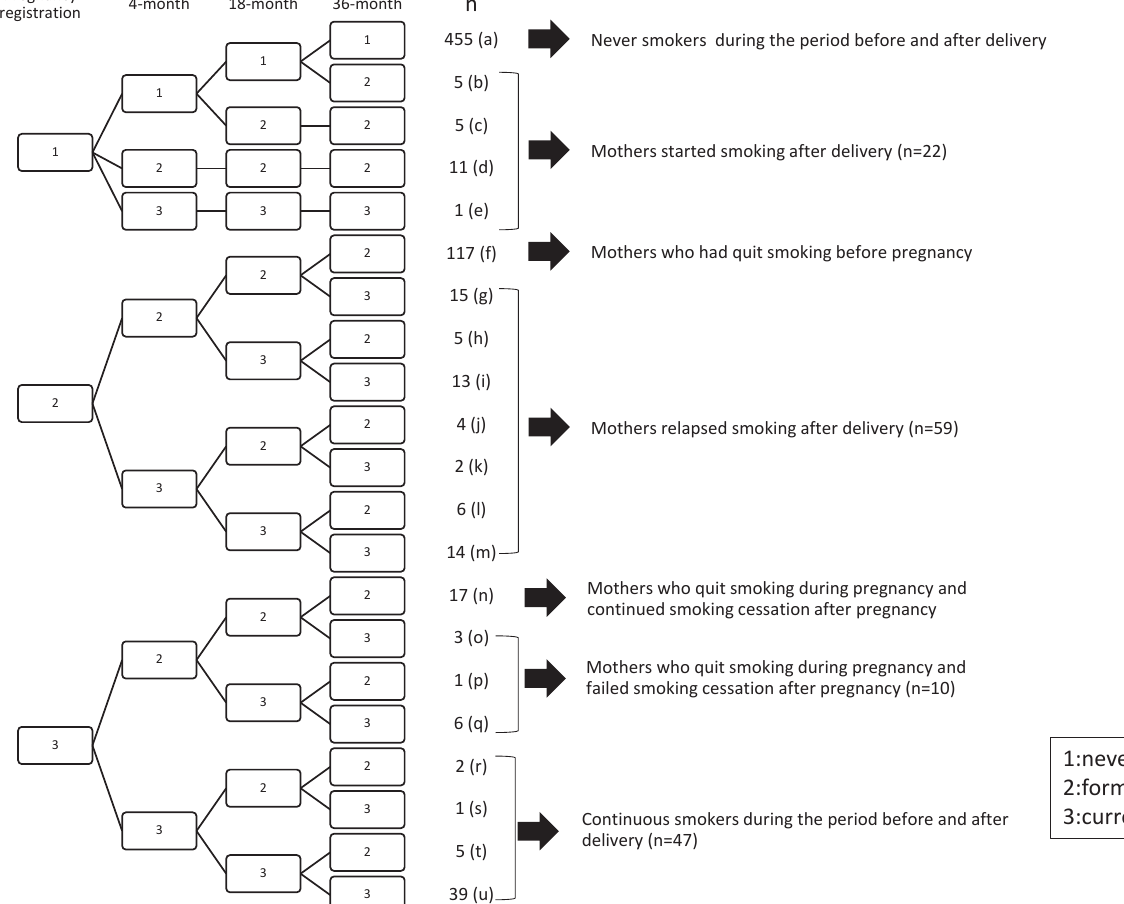
Figure 1. Tree diagram to describe maternal smoking status at pregnancy registration and health check-ups for their children at 4, 18, and 36 months of age (1: answer of “ never smoker ” , 2: answer of “ former smoker ” , 3: answer of “ current smoker ”